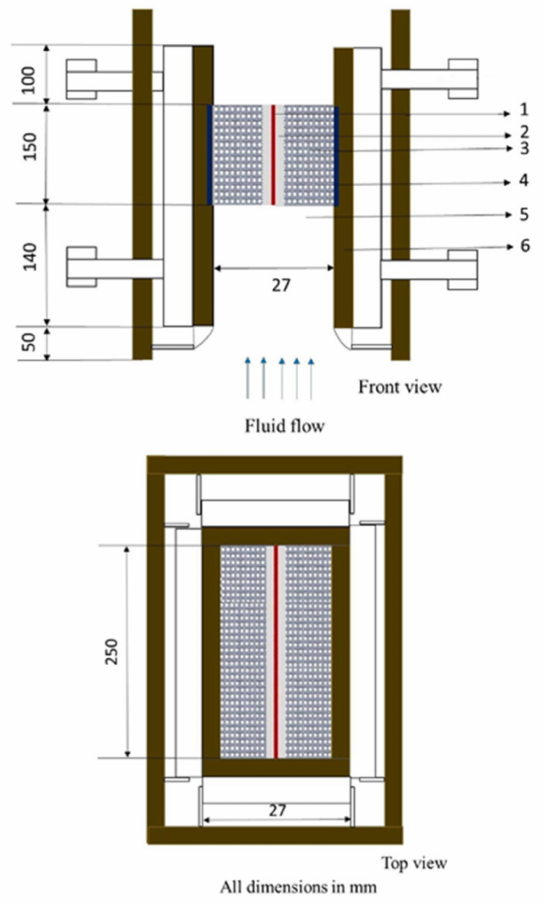
Figure 11. Sketch of experimental domain used by Kurian et al. [28]: (1) heater, (2) aluminum plate, (3) stacked wire-mesh porous media, (4) insulating material, (5) channel passage and (6) channel